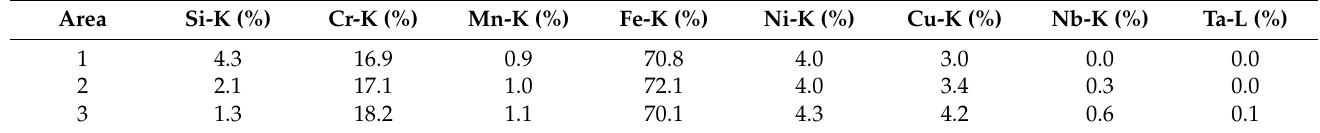
Table 2. The chemical composition of 17-4 PH steel (areas are shown in Figure 4).